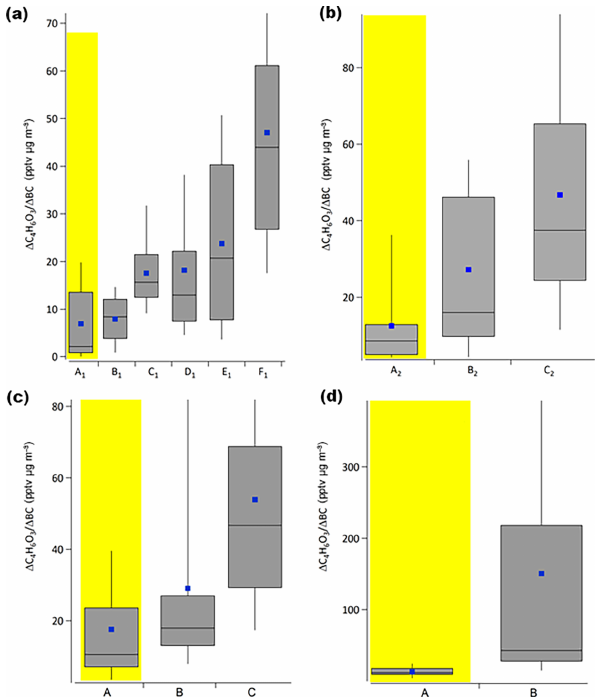
Figure 4. (cid:49) LMWOA /(cid:49) BC evolution (using C 4 H 6 O 3 as an ex- ample) across the various transects (A, B, C, etc.) of emission box flights. The yellow highlighted area represents the emission ratio (i.e. closest transect to the open pit mine). Box and whiskers rep- resent the 25th, 75th, 90th, and 10th percentiles. Blue data points represent the mean of the data. (a) Derived from F21, Fig. S4 in the Supplement (Syncrude-AU). (b) Derived from F21, Fig. S4 (Shell- JP), (c) Derived from F18, Fig. 3 (Syncrude-ML). (d) Derived from F17, Fig. S3